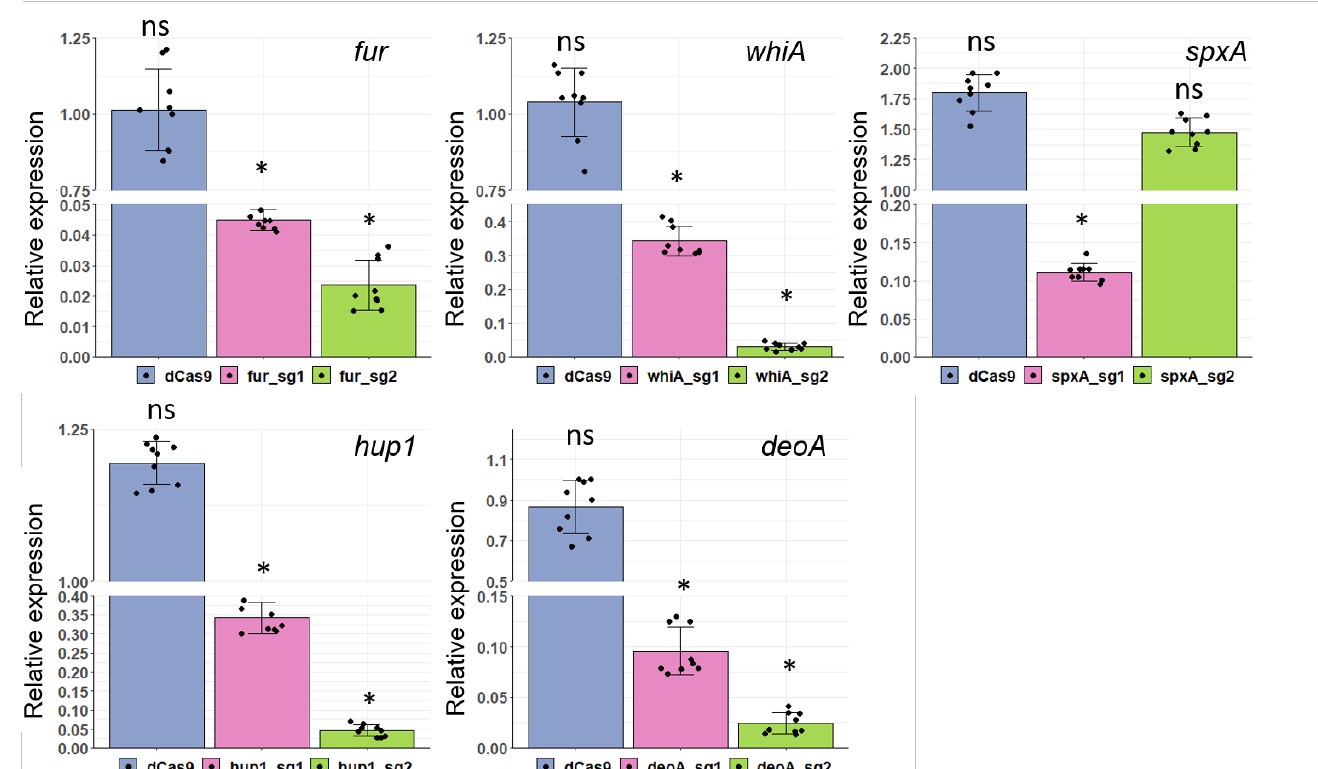
Figure 4. Efficiency of genes knockdown via CRISPRi in two mycoplasma species. Expression changes of target-genes ( fur , whiA , spxA and hup1 for M. gallisepticum and deoA for M. hominis ) in transformants expressing dCas9 and corresponding sgRNAs compared to the wild-type mycoplasma. dCas9–transformants that express dCas9 and don’t express sgRNAs; sg1–constructed sgRNA1,